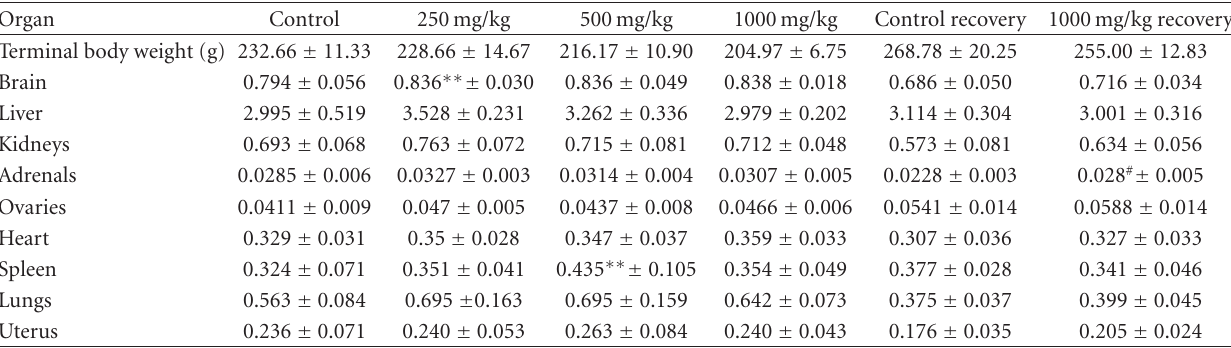
Table 9: Relative organ weights (% of fasting body weight; mean ± SD) in female rats treated with Zigbir (cid:2) orally for 90 days. Organ Control 250mg/kg 500 mg/kg 1000 mg/kg Control recovery 1000 mg/kg recovery Terminal body weight (g) 232.66 ± 11.33